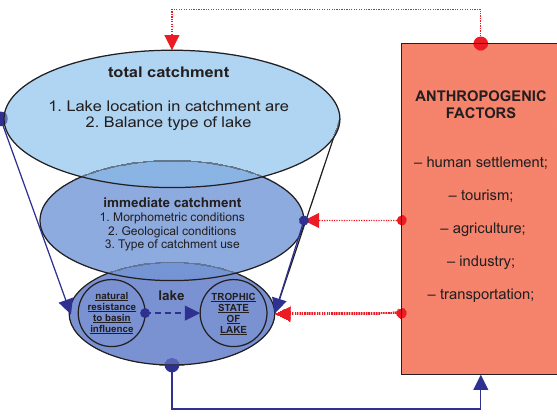
Fig. 1. Mutual impact of a loop system: anthropo - pressure-catchment-lake